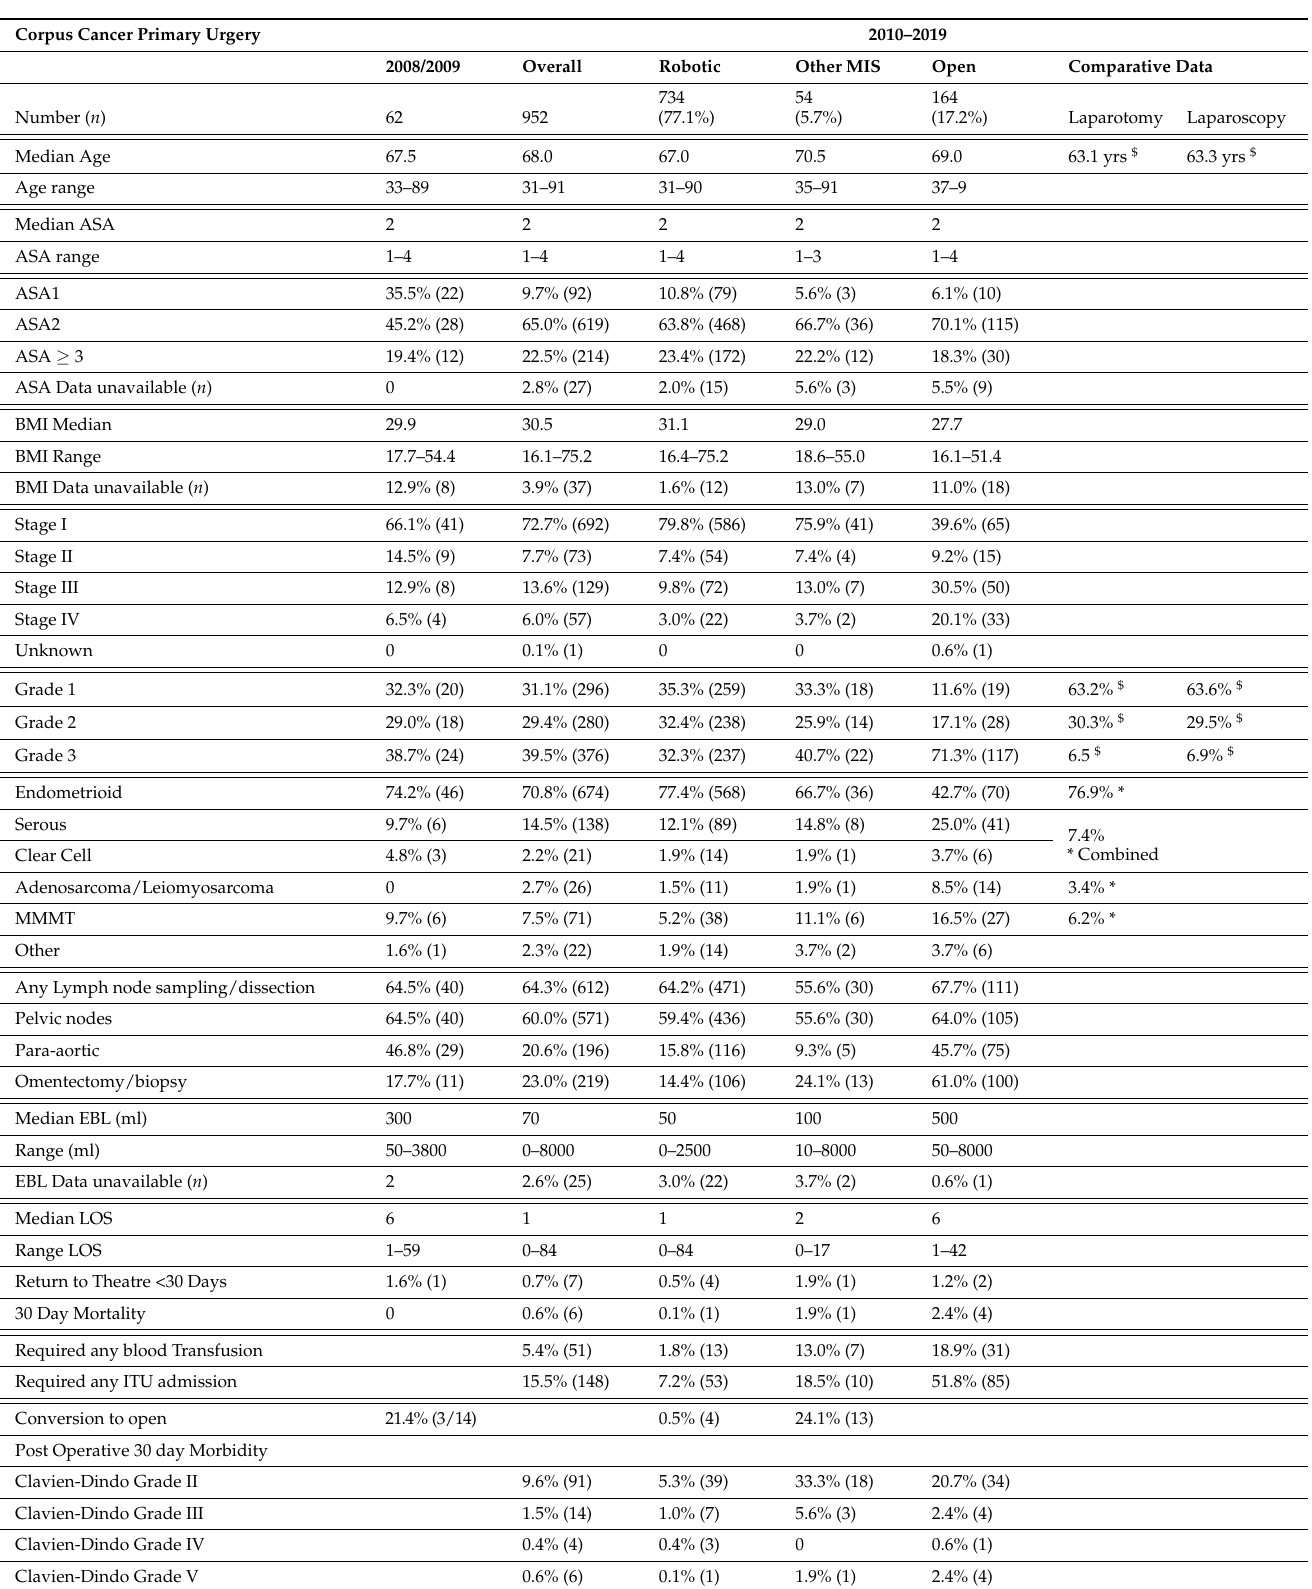
Table 1. Corpus Cancer Surgery 2008/2009 and 2010–2019 Patient demographics, surgical procedures and outcomes. * National Cancer Intelligence Network (NCIN) (2013). Outline of Uterine Cancer in the United Kingdom: Incidence, Mortality and Survival $ LACE